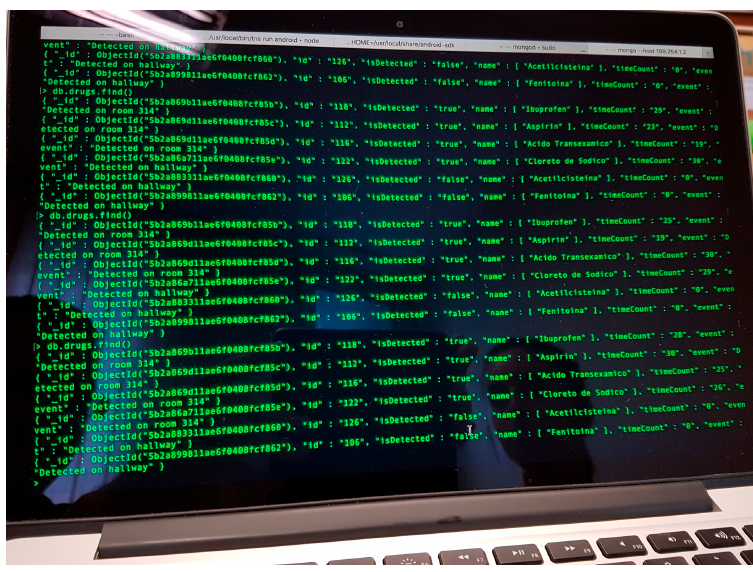
Figure 8. Screenshot of the MongoDB software [33], showing a list of the items registered in the database, together with their attributes.